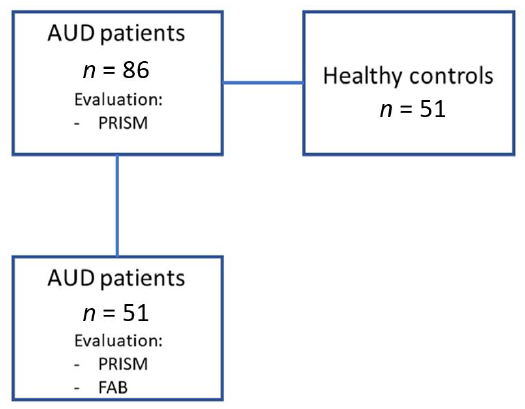
Figure 1. Diagram showing the design of the cross-sectional study.